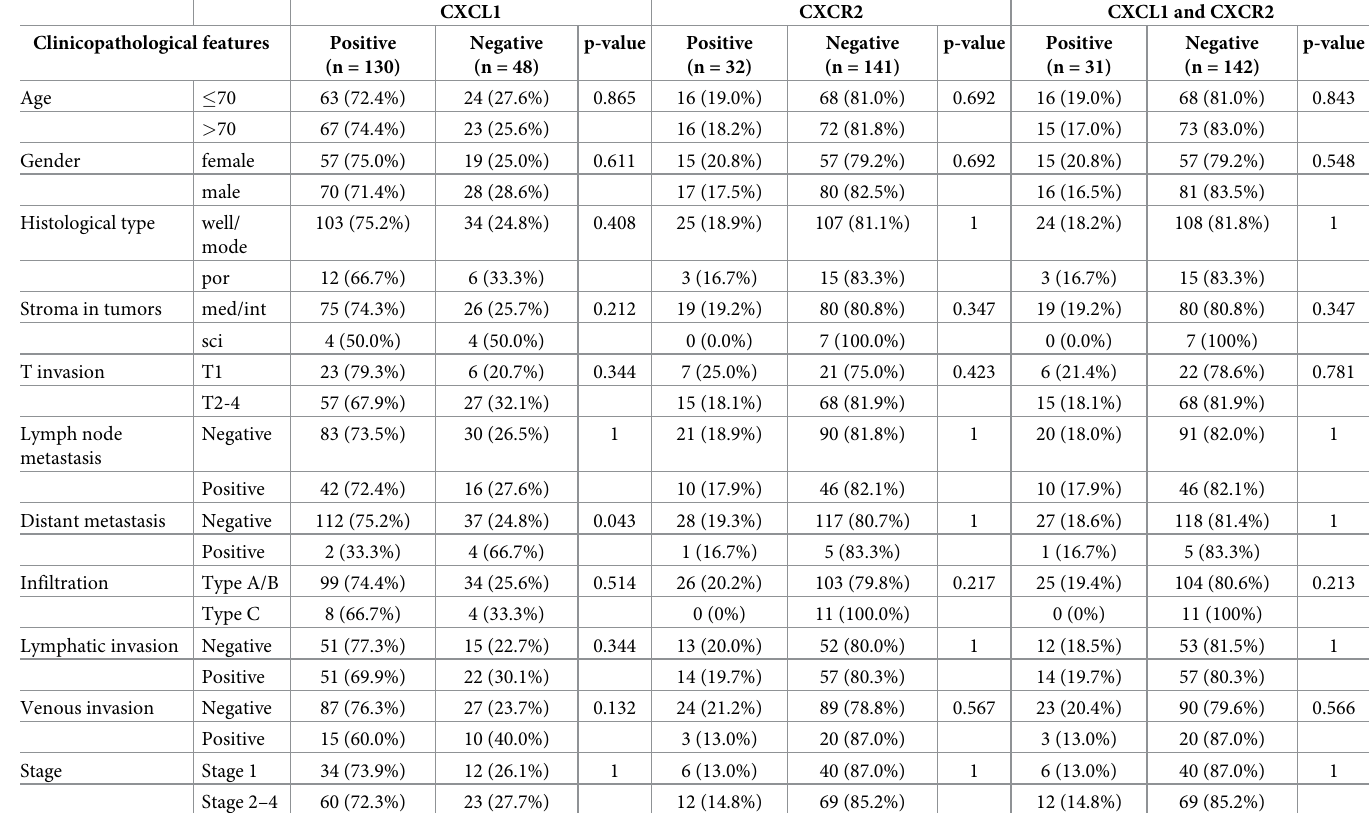
Table 1. The correlation between the clinicopathologic features and CXCL1 and/or CXCR2 in